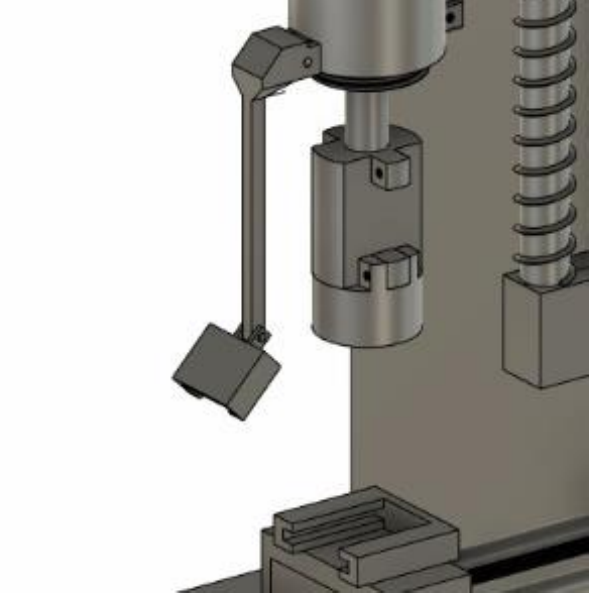
Figure 10. The model of the camera used in the proposed examination system. The camera is connected to the cover frame shown in (b) of Figure 5, and measures the TH in real time.